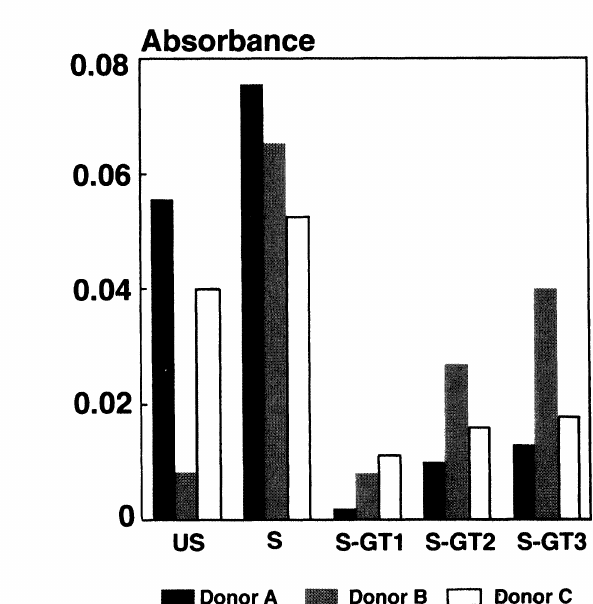
Fig. 6. Metabolic stimulation of gliotoxin-treated (I Ig/ mL) PMN. NBT reduction by unstimulated (US) PMN, un- stimulated gliotoxin-treated PMN, zymosan-stimulated (S) PMN, and zymosan-stimulated gliotoxin-treated (S-GT) PMN was measured spectrophotometrically at 570 nm wavelength with a reference wavelength of 630